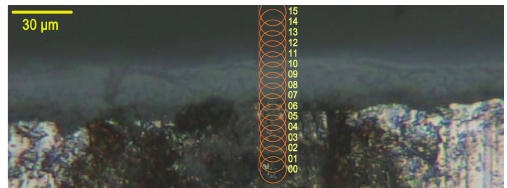
F 2: Positions of points for micro-Raman analyses perpendic- ular to the surface of sample.